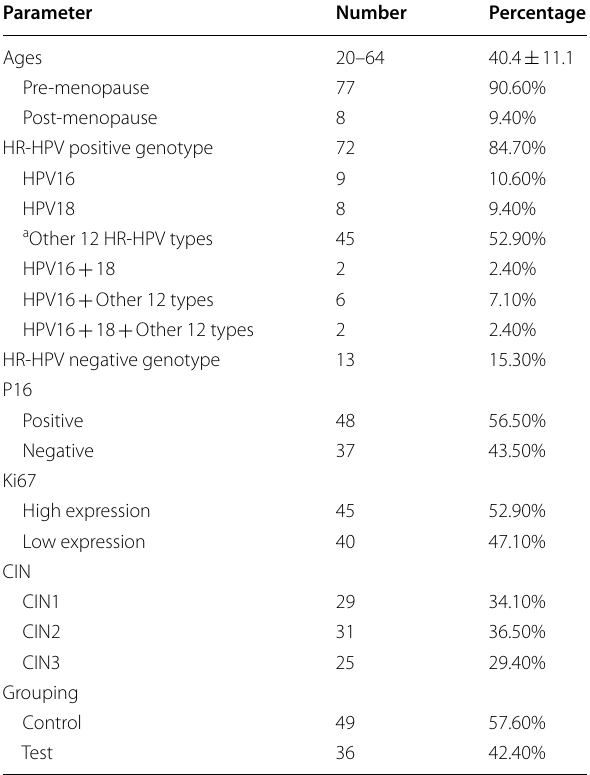
Table 1 The clinical data and pathological characteristics of 85 CIN